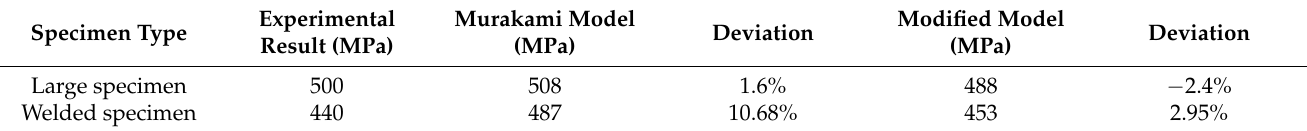
Table 5. Comparison between the Murakami model and the modified